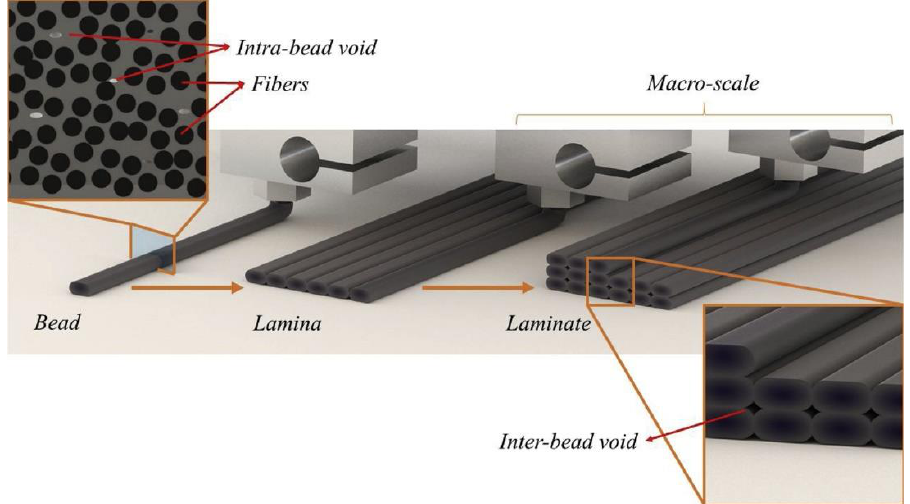
Figure 8. Intra-beads voids. Reprinted with permission from [35], 2020, Elsevier, Amsterdam, The Netherlands.